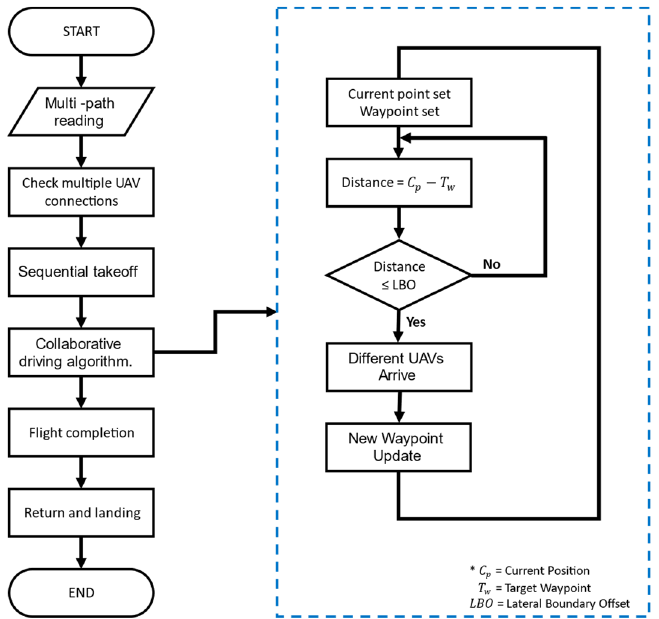
Figure 5. Collaborative driving algorithm of multiple unmanned aerial vehicles.